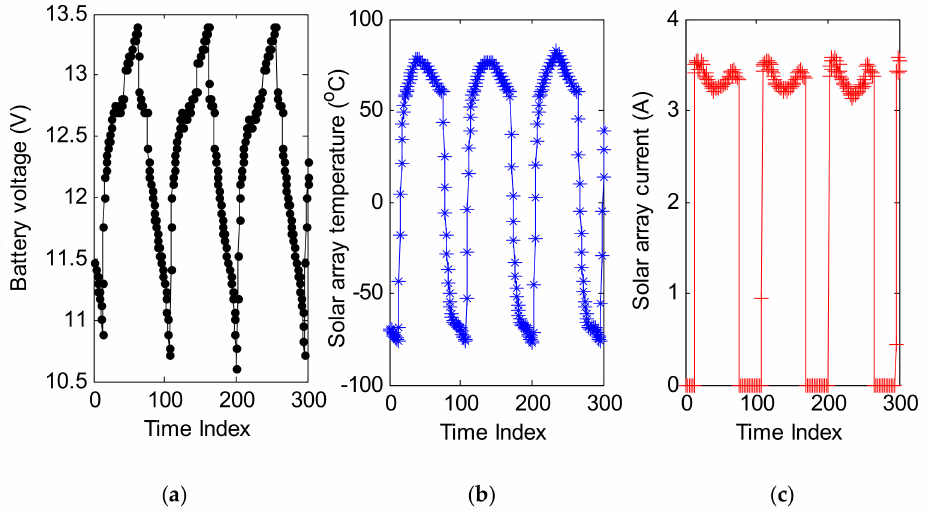
Figure 9. Three types of telemetry series. ( a ) Battery voltage; ( b ) Solar array temperature; ( c ) Solar array